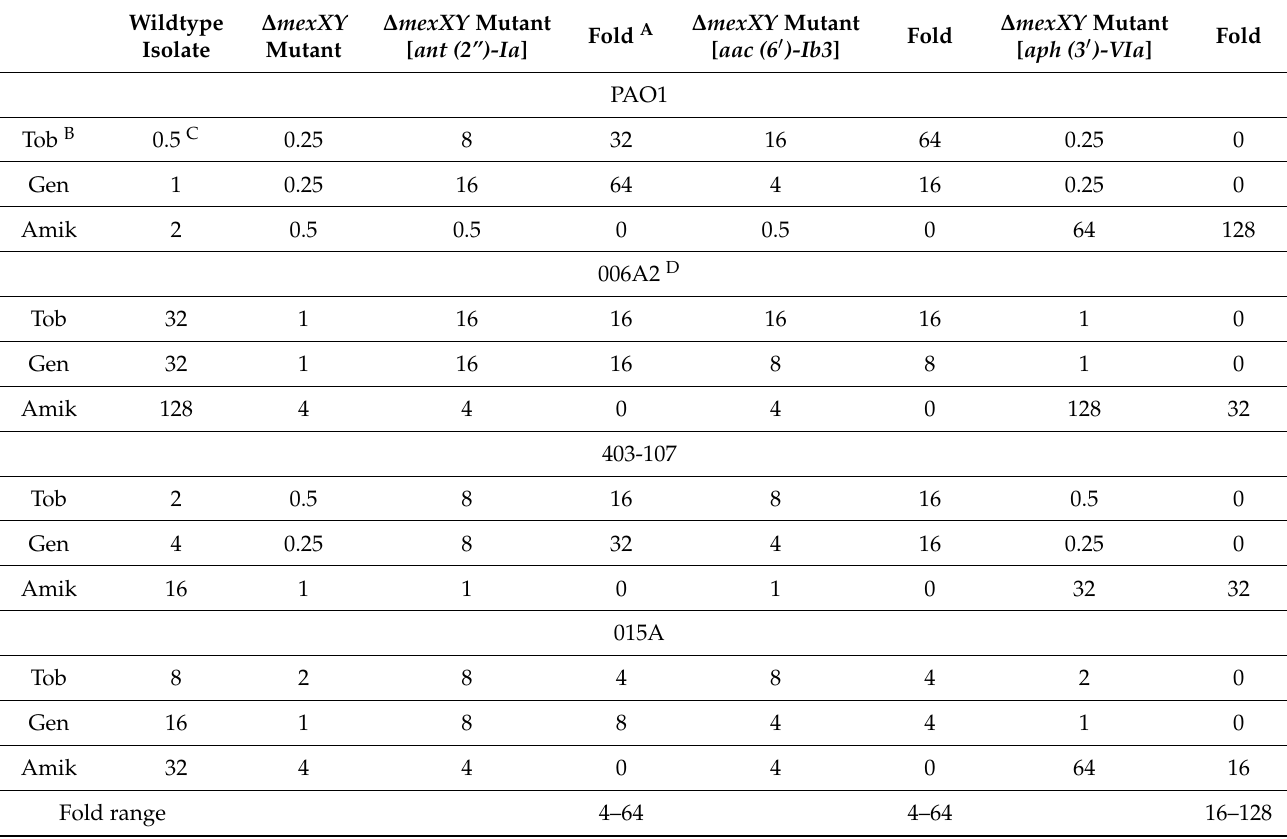
Table 2. The effects of AMEs on MICs in the absence of MexXY.